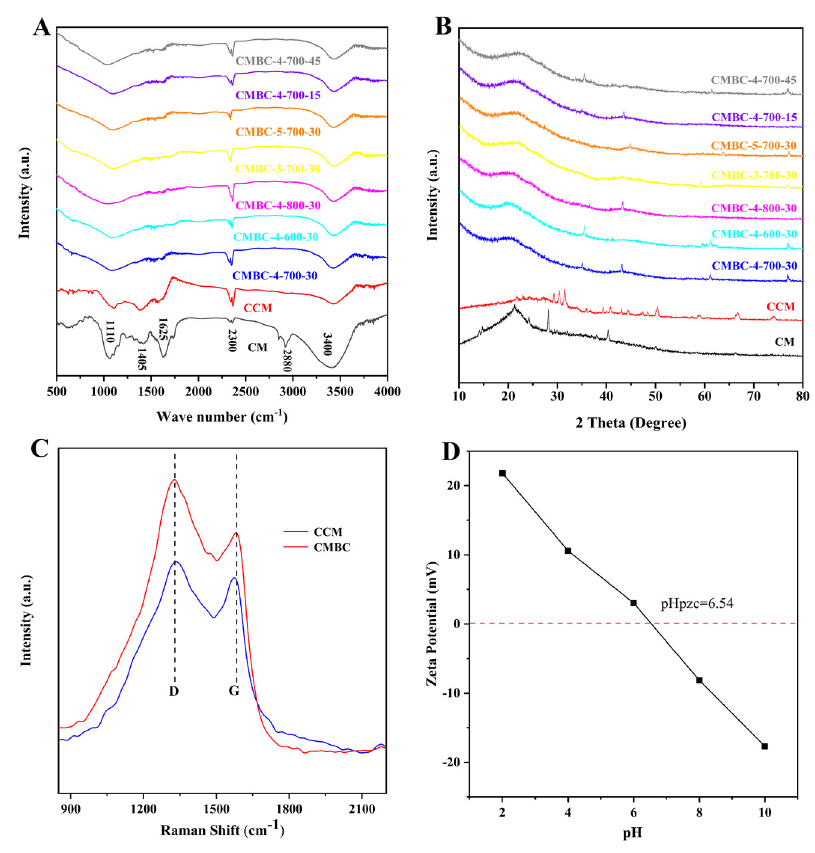
Figure 2. ( A ) FT-IR, ( B ) XRD tests of CM, CCM and CMBC prepared at different conditions, ( C ) Raman tests of CCM and CMBC-4-700-30 and ( D ) zeta potential test of CMBC-4-700-30.